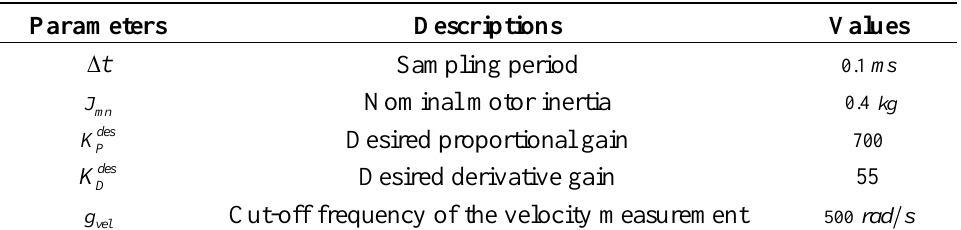
Figure 6. Experimental Setup. Table 1. Experimental setup